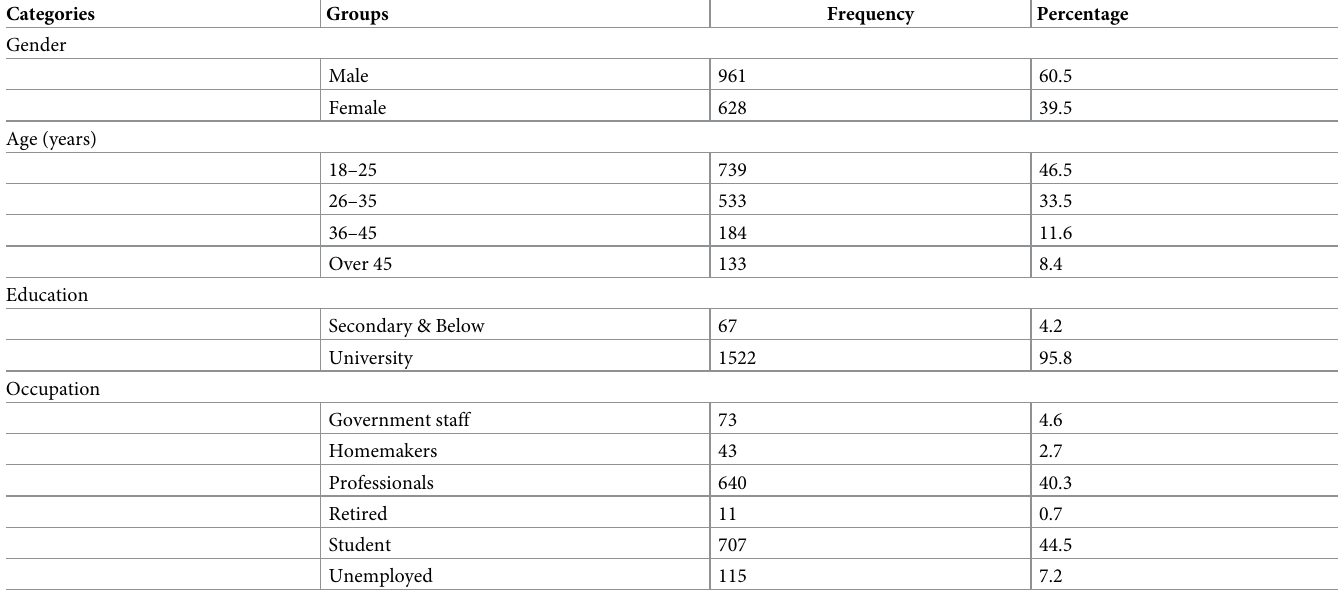
Table 1. Sociodemographic profile of the participants.